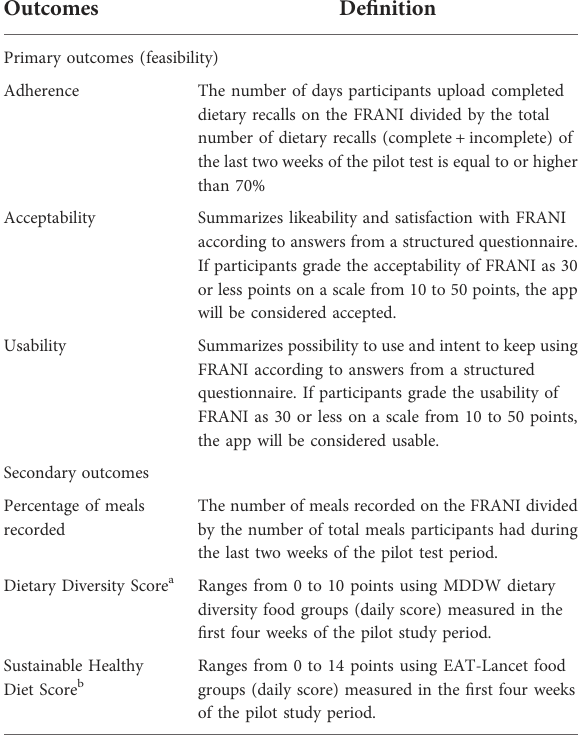
TABLE 2 Domains and outcome measures for the FRANI pilot test. TABLE 3 Questionnaire about acceptability and usability of the FRANI